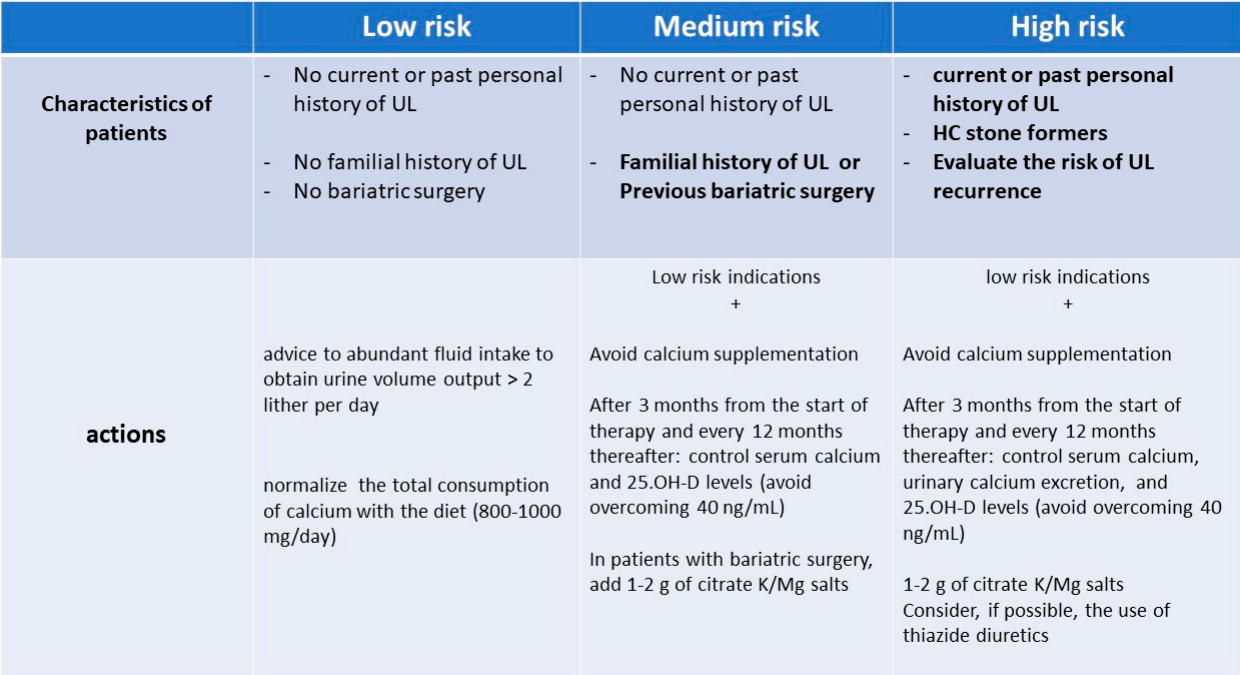
Figure 4. De fi nition of UL risk and suggested actions to be undertaken in subjects where there is a strong indication for prescribing vitamin D and/or calcium supplementation (see